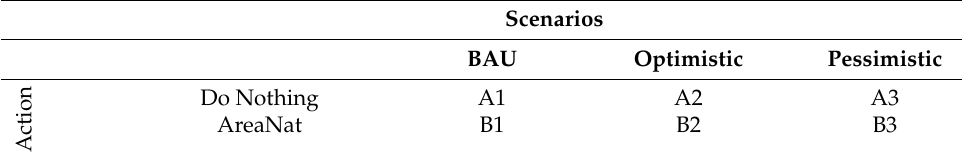
Table 4. Scenario building